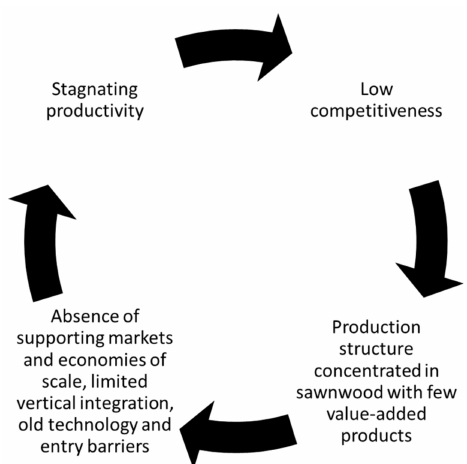
Figure 5. Productivity trap in the Mexican forest sector (adapted from OECD